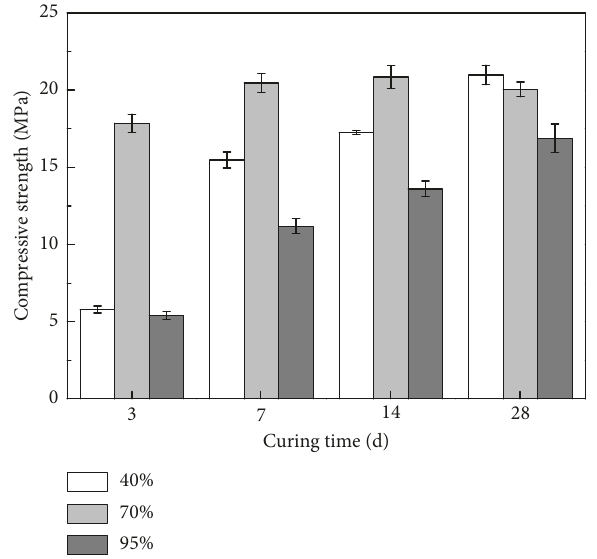
Figure 8: Compressive strength of CNSCMs cured under different levels of humidity and for different periods.